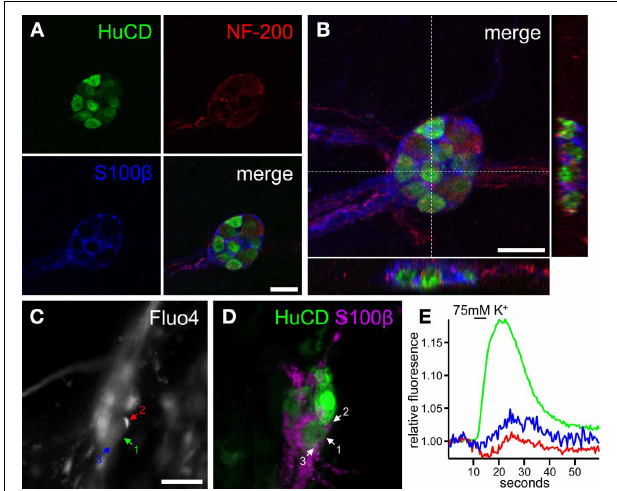
FIGURE 6 | Interactions between enteric neurons and glia in the human enteric nervous system. (A) Individual confocal images of a human submucosal ganglion obtained from a duodenal biopsy in which enteric neurons are labeled with antibodies for HuCD (green) and NF-200 (red) and enteric glia are immunostained for S100 β (blue). (B) Maximum projection of the same ganglion as in (A) with orthogonal X (bottom) and Y (right) views. Note how enteric neurons and glial cells are closely packed together within a dense ganglionic capsule. (C) Gray scale fluorescence image of a human submucosal ganglion loaded with the Ca 2 + indicator Fluo4. (D) Image of the same ganglion as in (C) , immunostained for HuCD (green) and S100 β (magenta). (E) Ca 2 + responses of a neuronal cell body and two glial cell processes [color-coded numbers in (C) and numbers in (D) ] upon 75mM K + depolarization. Scale bars: 25 μ m (A,B) , 50 μ m (C)